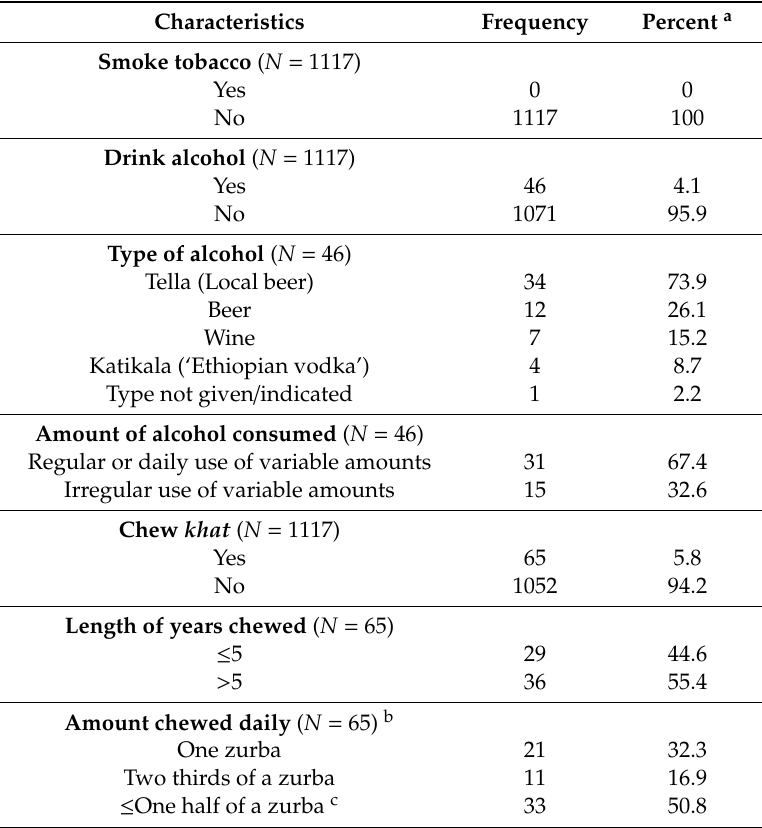
Table 3. Social drugs used among pregnant women prior to admission to JUMC, Ethiopia, February to June 2017.